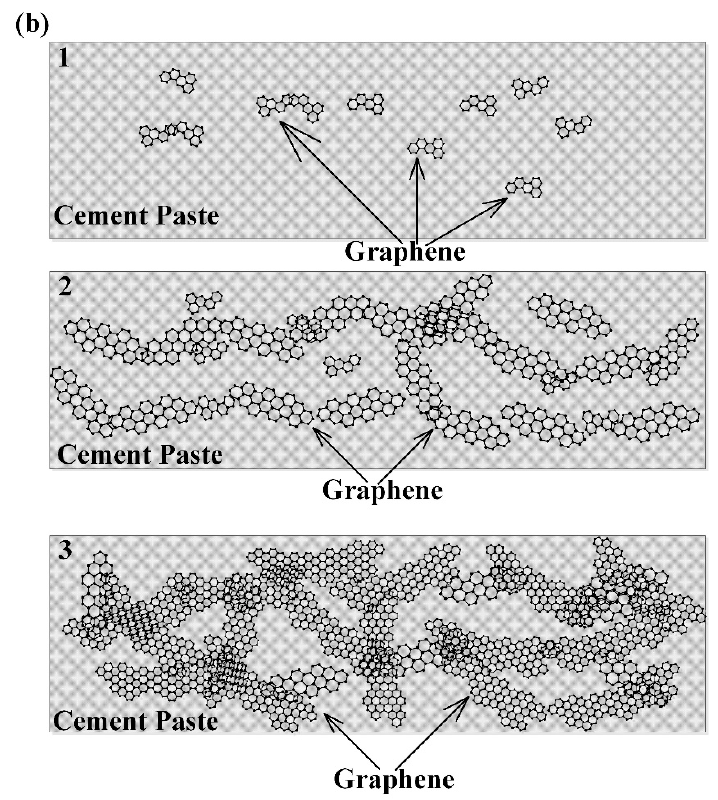
Figure 4. ( a ) Conductivities vs. graphene content for graphene/cement composites obtained by AC measurement. ( b ) Model of graphene distributed and interconnected in the composites.